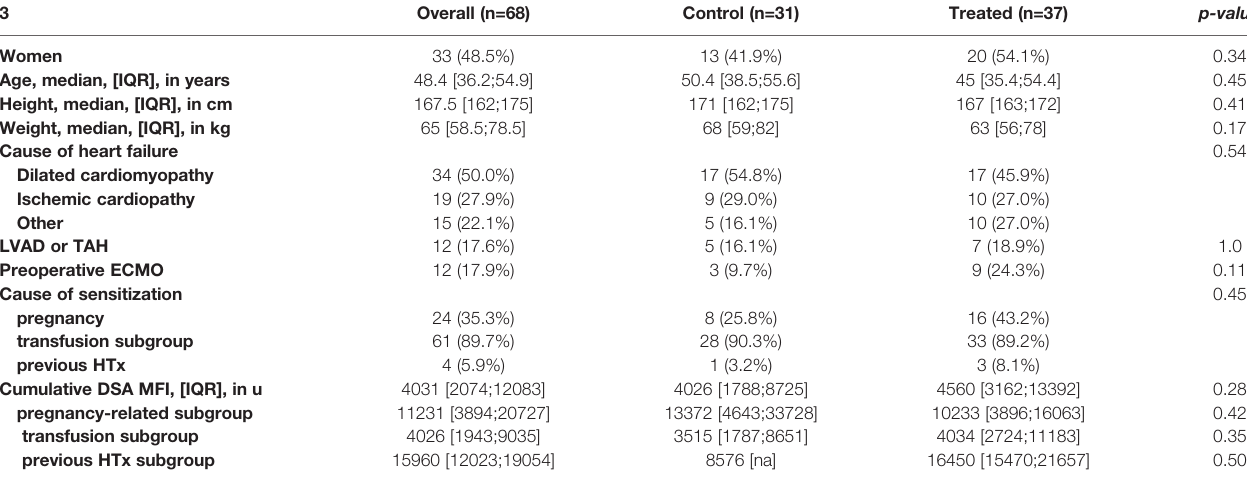
TABLE 1 | Baseline